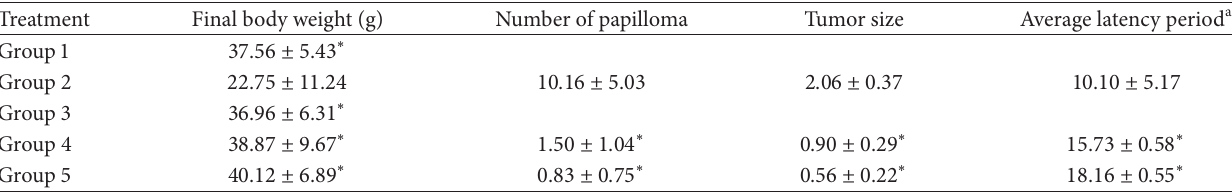
Table 4: Chemopreventive effect of palmatine against DMBA and croton oil induced skin carcinogenesis in